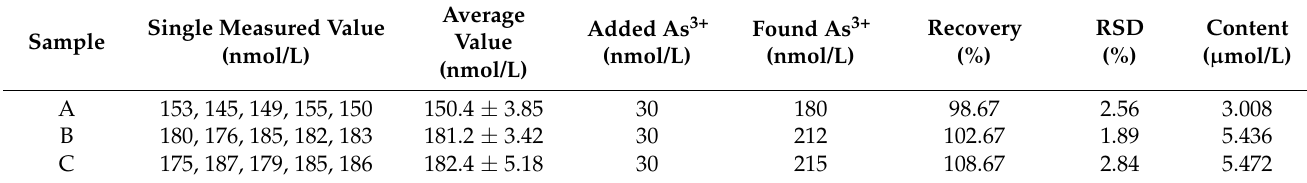
Table 3. Analytical results of As 3+ in